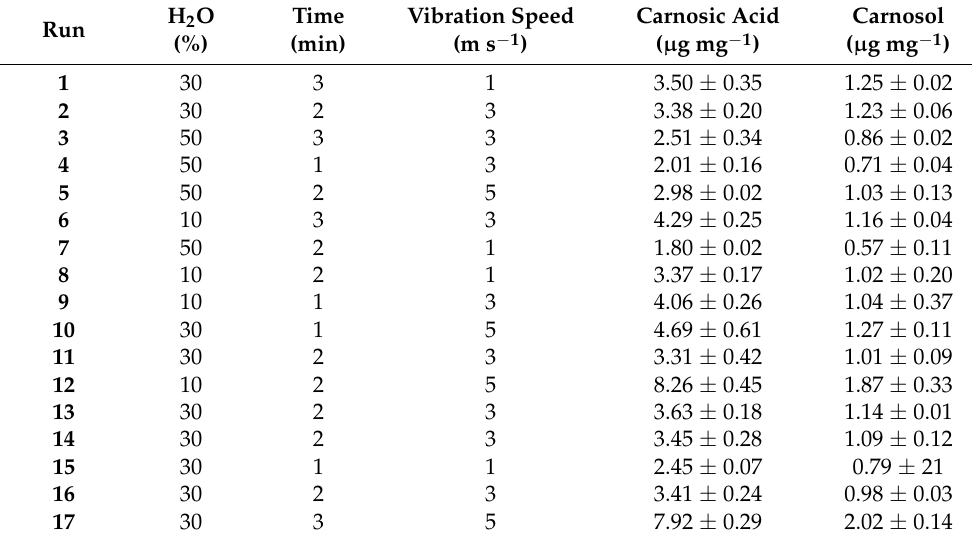
Table 2. Experimental matrix and values ( µ g mg − 1 of the plant material) of observed response for the extraction with choline chloride:lactic acid (1:2 molar ratio) obtained by mechanochemical extraction (MCE). The results are expressed as mean value ± standard deviation ( n =